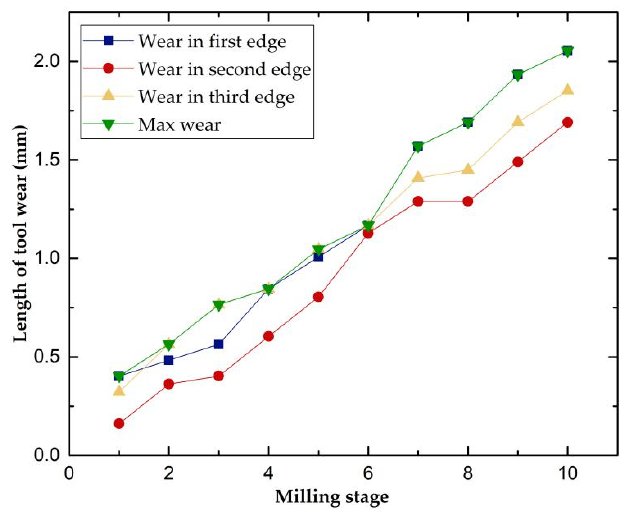
Figure 7. Evolution of tool wear.